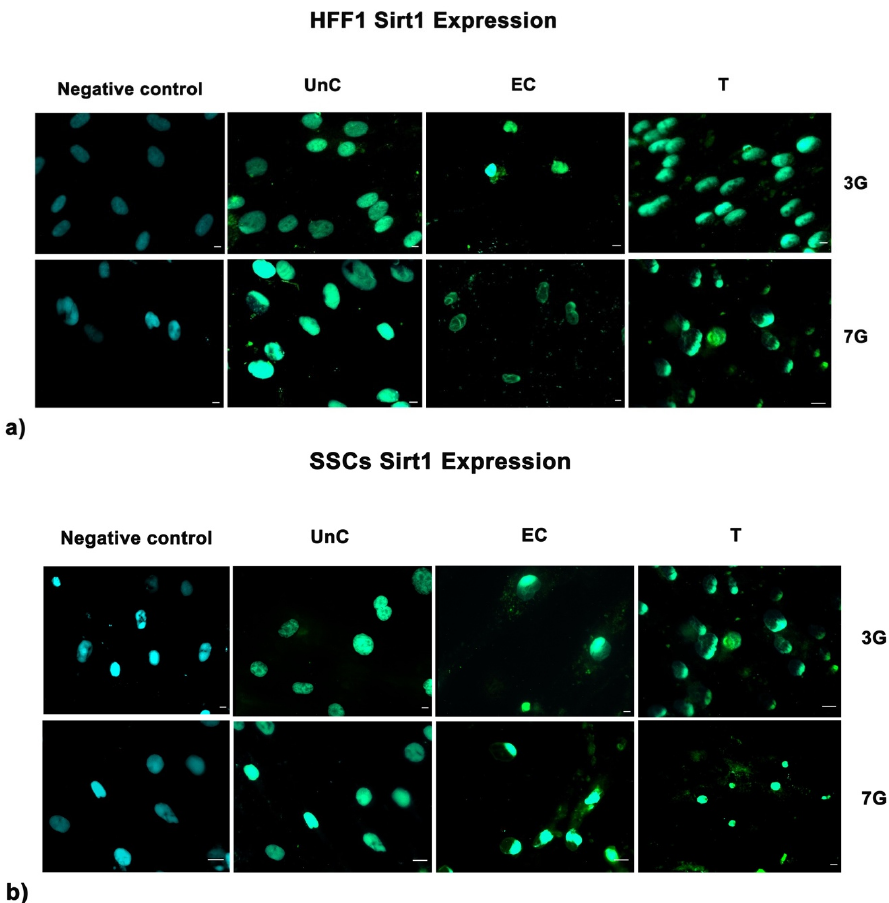
Figure 7. Analysis of SIRT1 expression after oxidative stress. SIRT1 images were acquired in HFF1 ( a ) and SSCs ( b ) exposed to UV treatment (EC) and cells pre-treated with NanoPCL-M and then exposed to UV radiation (T). Unexposed control cells were cultured in basic growing medium (Un-C). Cells stained with secondary antibody without any primary antibody were used as the negative control. Figures are representative of different independent experiments. For each differentiation marker, fields with the highest yield of positively stained cells are shown. Nuclei are labelled with 4,6-diamidino-2-phenylindole (DAPI, blue). Scale bars: 40 µm.